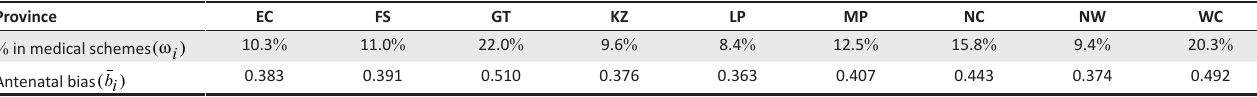
TABLE 1: Antenatal bias levels by